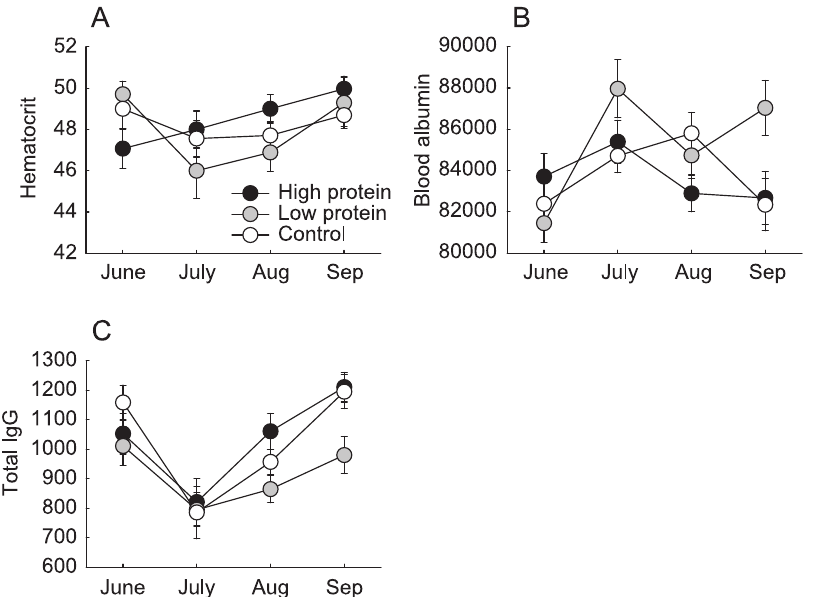
Figure 5. Condition indices of female voles from experimental populations (mean ± se). (A) haematocrit, (B) plasma albumin, (C) total IgG antibody titer.